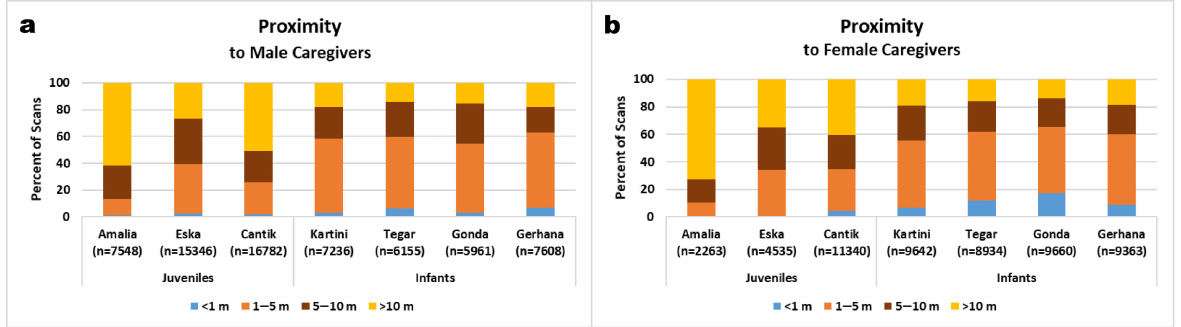
Figure 8. Proximity to male ( a ) and female ( b ) caregivers per subject over the entire observation period of 18 months (Amalia over 9